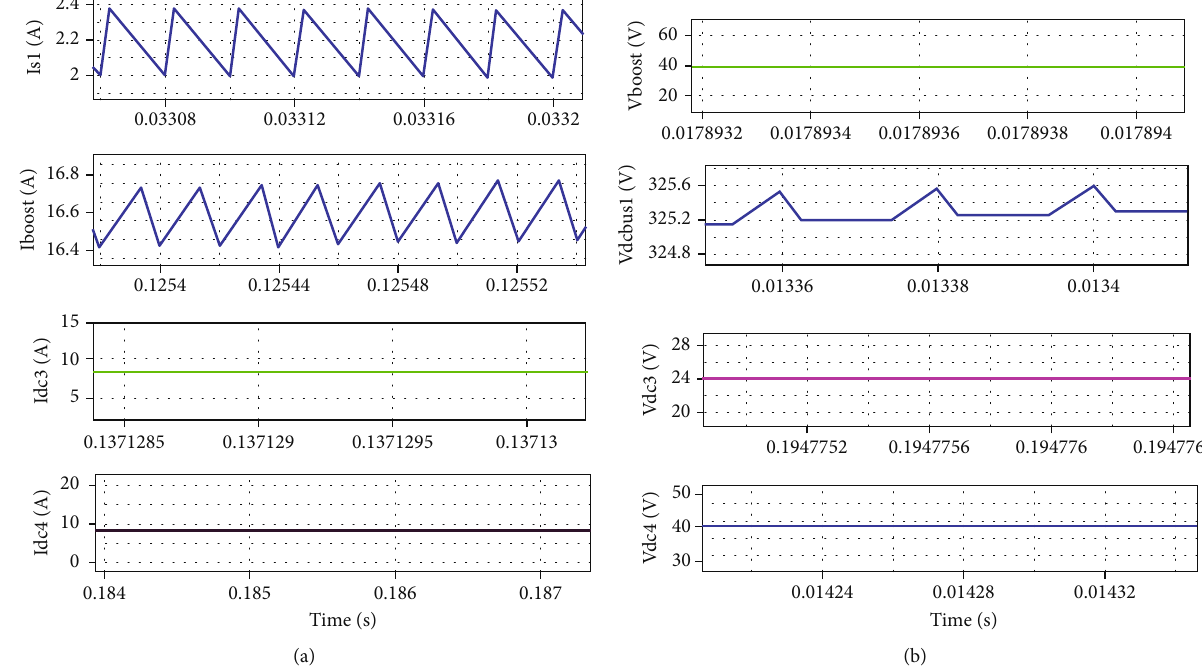
I I , and I and (b) DC boost voltage V s 1 , boost , dc3 dc4